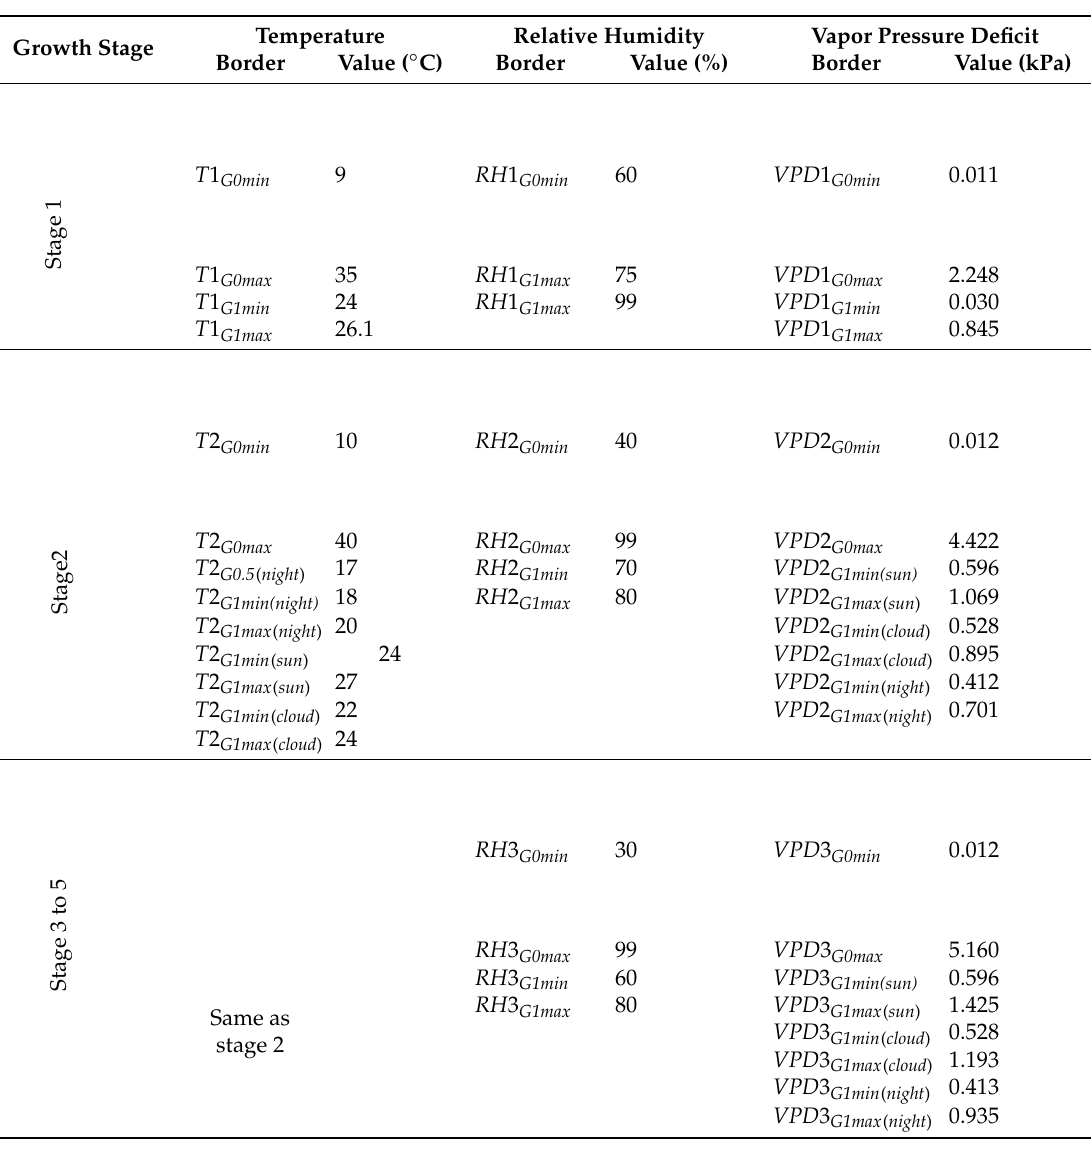
Table 1. Reference values of air temperature, relative humidity and vapor pressure deficit in di ff erent growth stages and light conditions for tomato [16,26,29,31]. G0: index of failure, G0.5: index